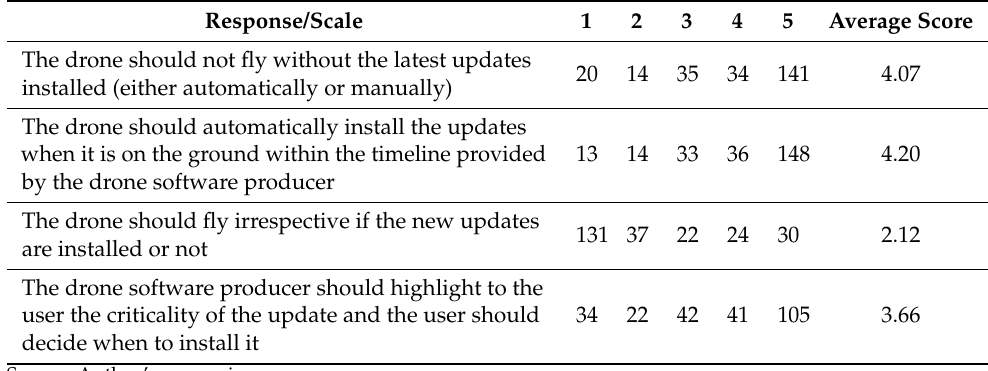
Table 3. Preventive measures for proper install of